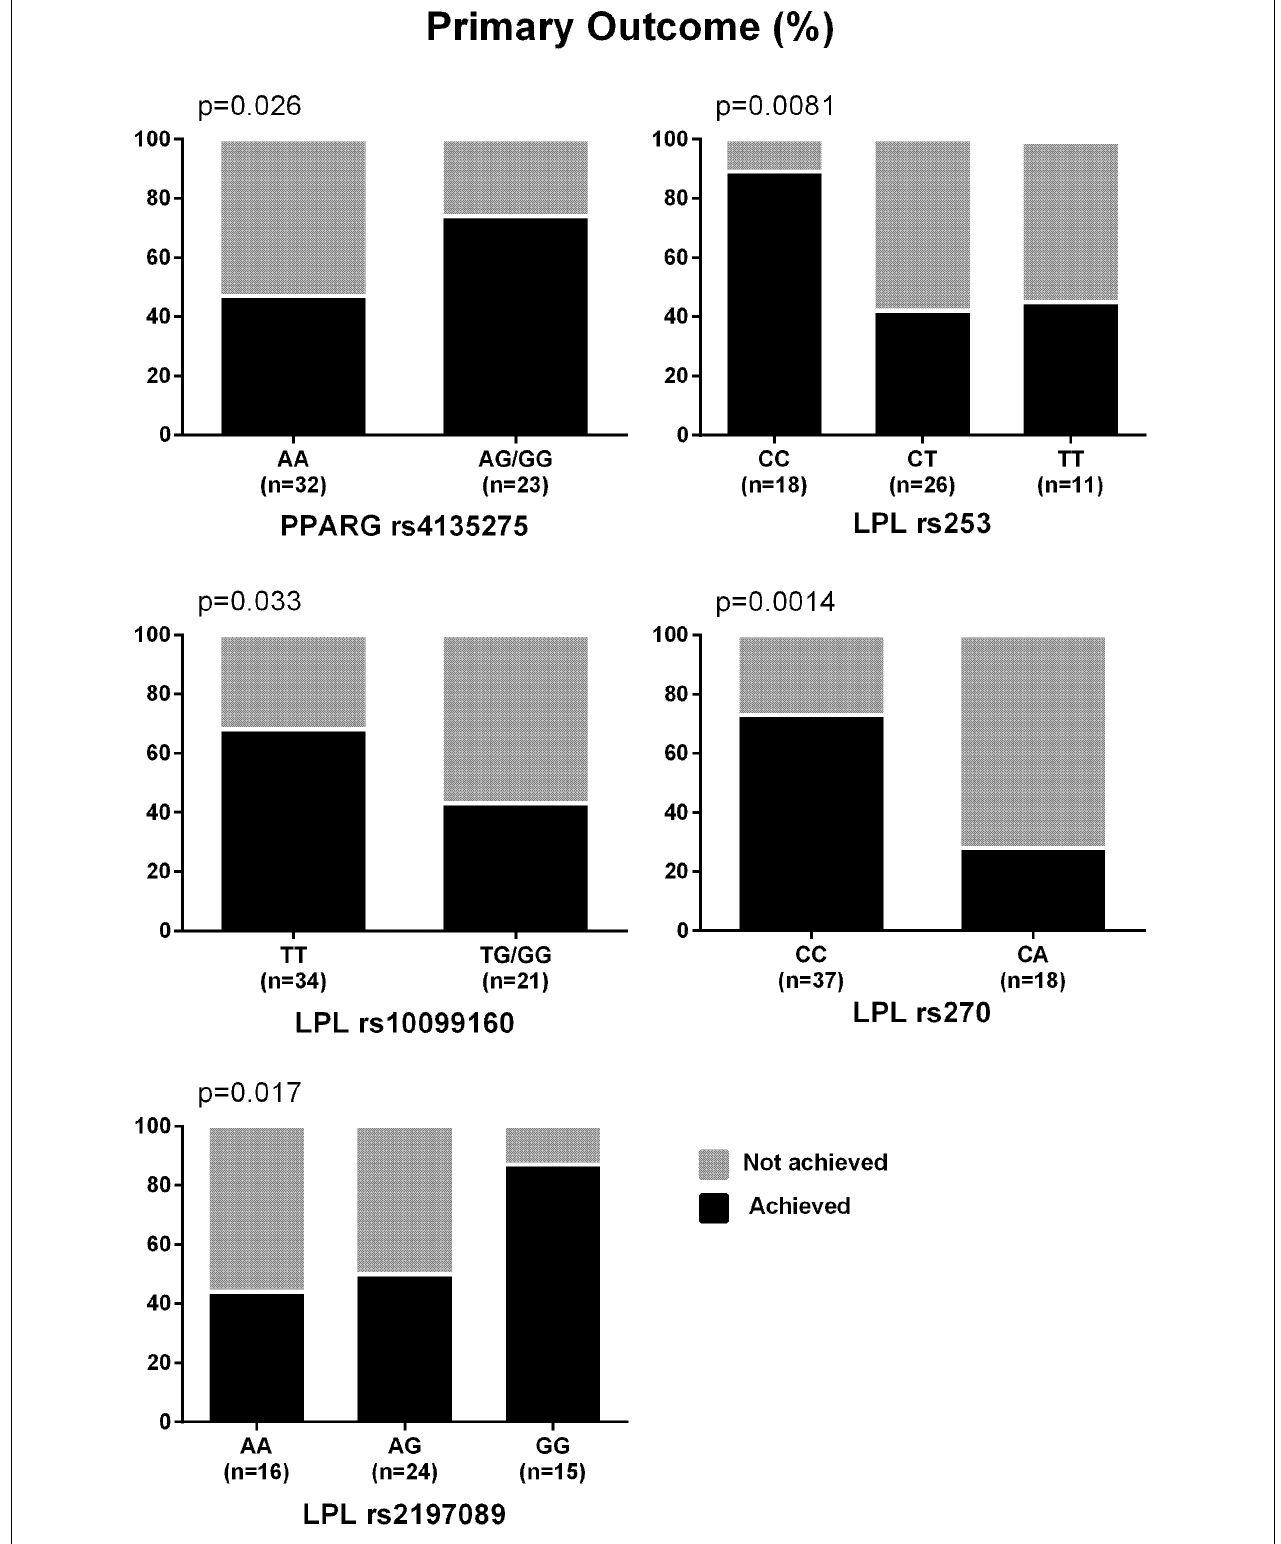
FIGURE 1 | Percentages of participants who achieved the primary outcome. Primary outcome was defined as reduction in NAS ≥ 2 (at least one-point improvement in more than one liver histology category without any worsening of fibrosis). P -values from Cochran Armitage trend tests are shown.